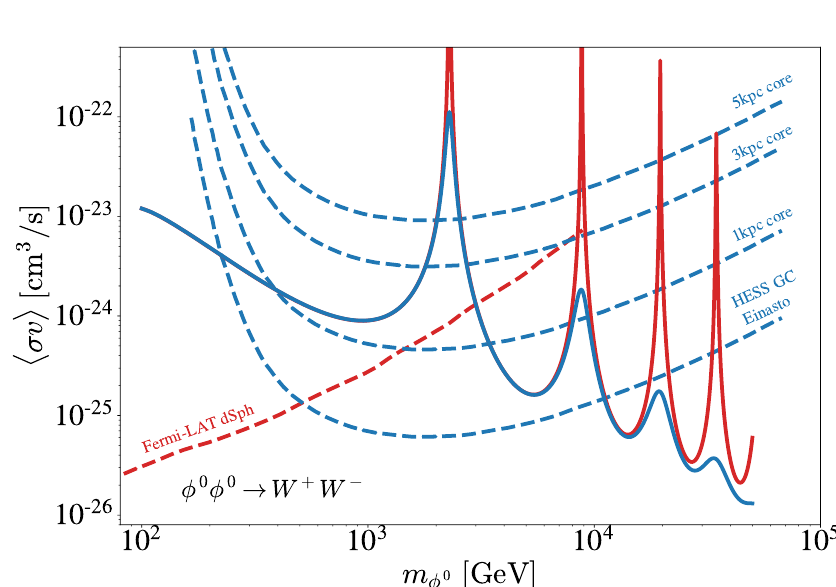
Figure 6: The annihilation cross section for φ 0 φ 0 → W + W − including the Sommer- feld enhancement with velocities consistent with the galactic center (light blue), and dwarf spheroidal galaxies (red) for comparison with H.E.S.S. (dashed light blue) and Fermi-LAT (dashed red) bounds on this annihilation channel based on gamma rays,